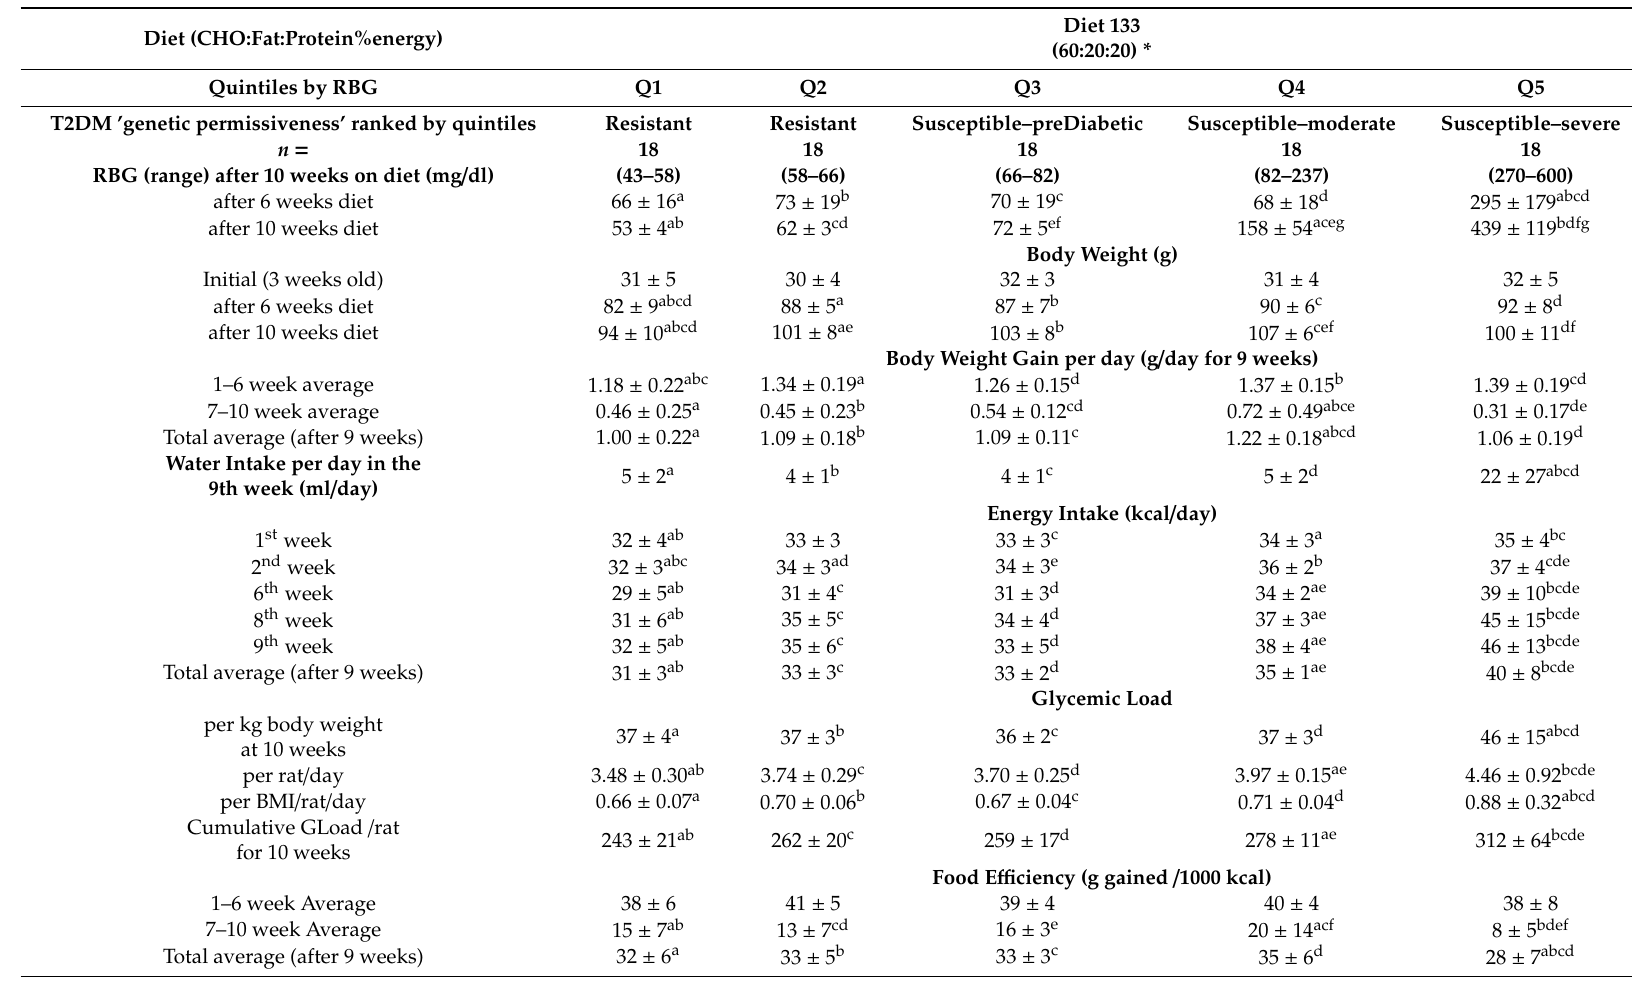
Table 4. (Experiment 2). Quintiles of RBG along with diabetes metagenetic profile for 90 male Nile rats (3 weeks old) fed semipurified hiCHO Diet 133 (60:20:20)* for 10 weeks, then subdivided into ’resistant’ or ’susceptible’ quintiles based on RBG < 75 mg / dl > , respectively. (NR Studies 130, 132, 144, 148, 150, 151,